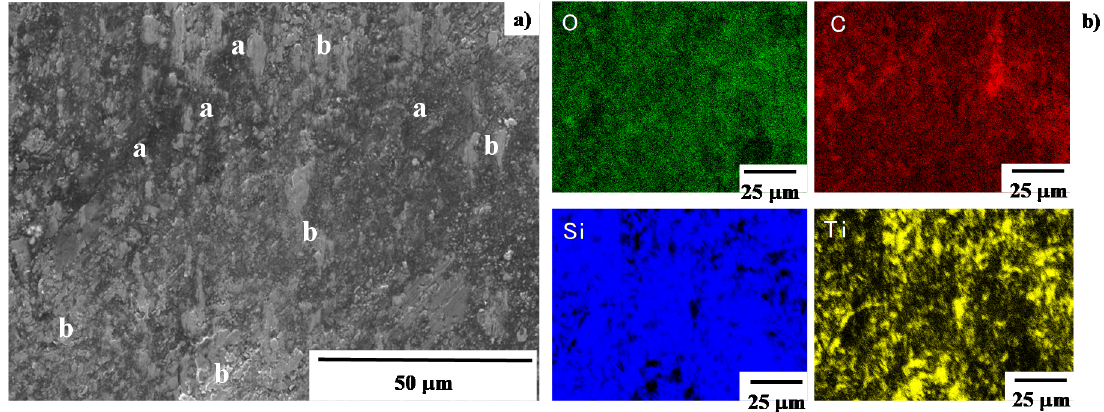
Figure 9. SEM–EDX analyses on the contact interface at the A-region. ( a ) SEM image on the A-region, and ( b ) element mapping of oxygen, carbon, silicon and titanium on the A-region.